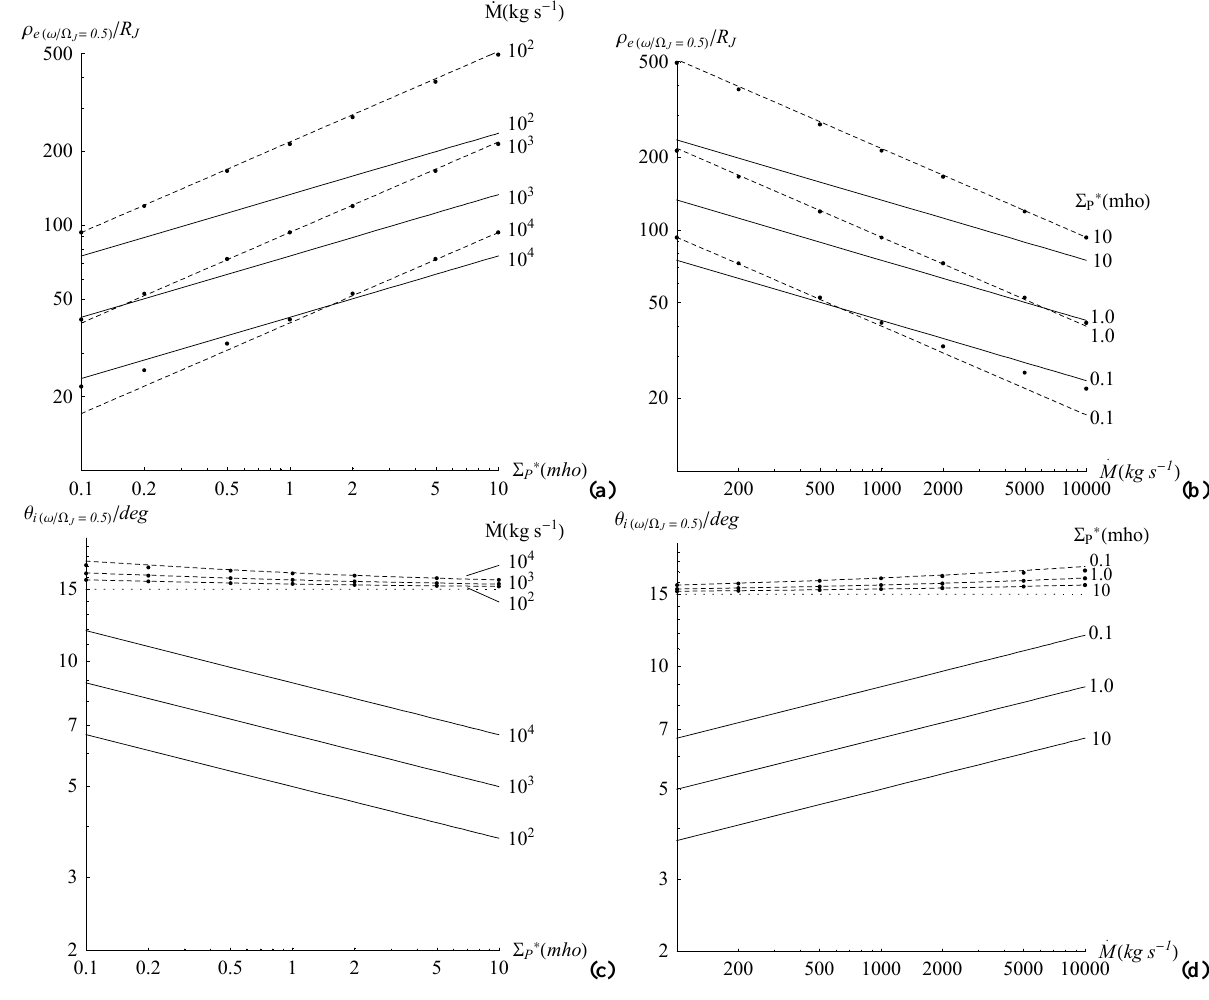
Fig. 8. Plots showing the location of plasma corotation breakdown, specifically where (ω/(cid:127) J ) = 0 . 5, and its dependence on the system parameters 6 ∗ and ˙ M . Plot (a) shows the equatorial distance at which (ω/(cid:127) J ) = 0 . 5 versus 6 ∗ in log-log format for ˙ M = 100 , 1000 and P P = 0 . 1, 1 and 10mho. Solid lines give results for the dipole 10000kgs − 1 , while (b) shows this distance similarly plotted versus ˙ M for 6 ∗ P field obtained from Eqs. (13) and (14), while the dashed lines show corresponding results derived from the power law field approximate solutions for the current sheet model Eqs. (27) and (28). The solid dots provide spot values obtained from numerical integration of the full current sheet solution, whose ˙ M (in (a)) and 6 ∗ (in (b)) values are obvious from their close association with the corresponding dashed lines. P Corresponding plots of the ionospheric co-latitude at which (ω/(cid:127) J ) = 0 . 5 are shown versus 6 ∗ and ˙ M in (c) and (d) . The horizontal dotted P line shows the latitude of the field line from infinity in the current sheet field